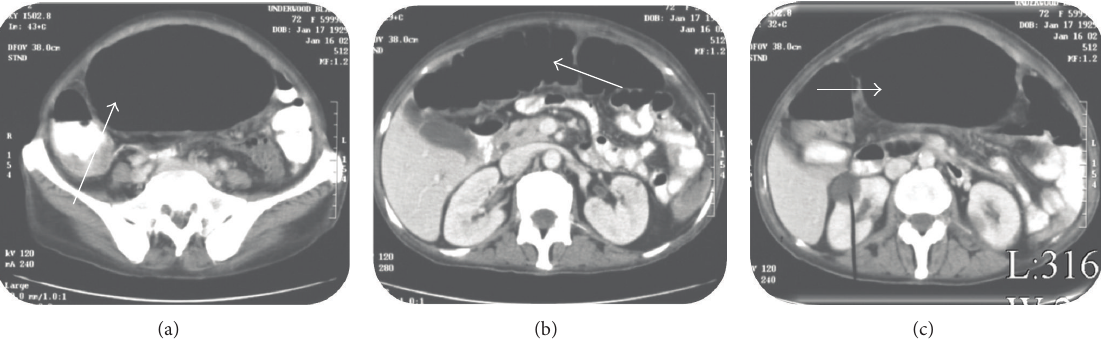
Figure 2: ((a), (b), and (c)) Abdominal CT showing air fluid level with a dilated loop of sigmoid colon.